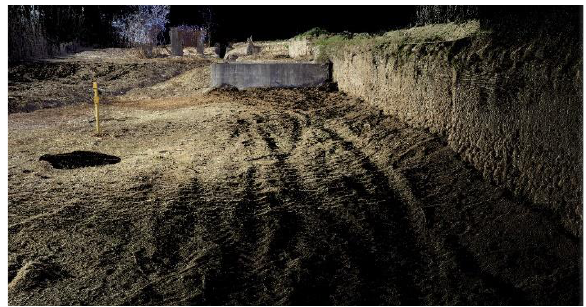
Figure 18. Exterior survey with laser scanning in 2018.